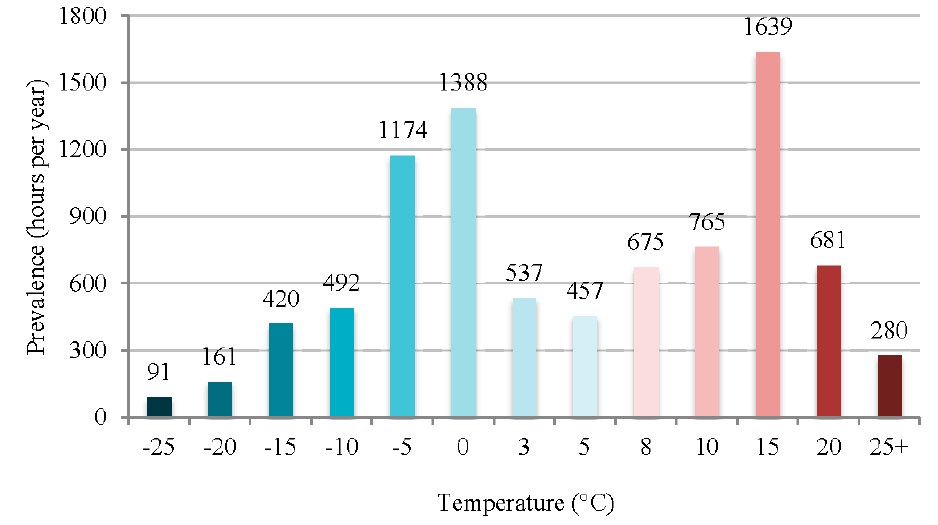
Figure 4. Outdoor air temperature annual distribution histogram.